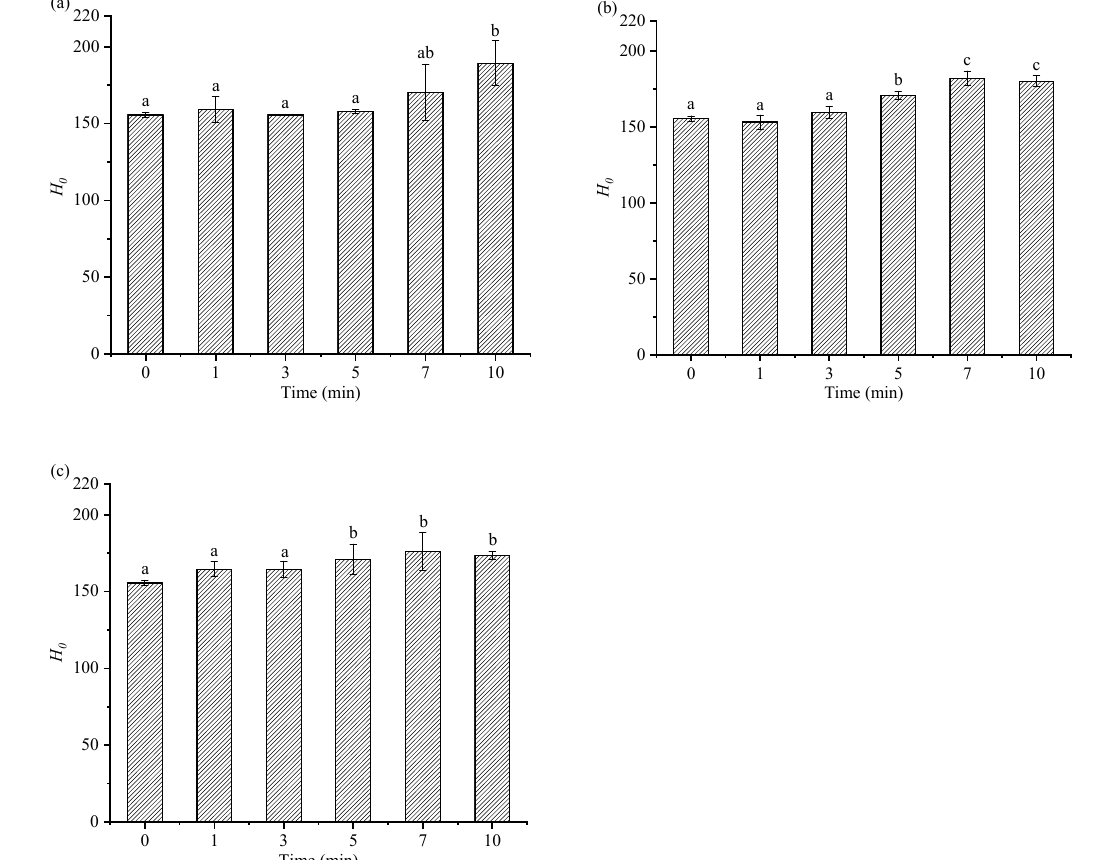
Figure 2. Surface hydrophobicity (H 0 , × 100,000) of goat milk β -lactoglobulin samples treated at di ff erent amplitudes (20% ( a ), 30% ( b ), 40% ( c )) and di ff erent treat times (0, 1, 3, 5, 7, 10 min). Completely di ff erent lowercase letter indicates significant di ff erences at p < 0.05.